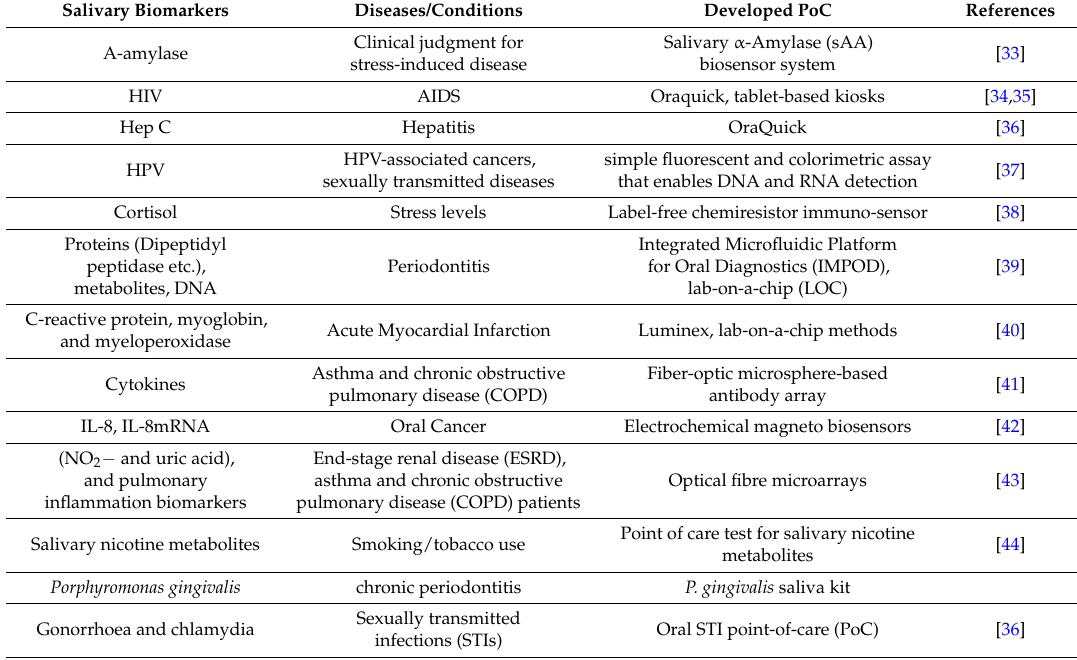
Table 1. Description of Point-of-care (PoC) devices for detection of diseases through specific salivary